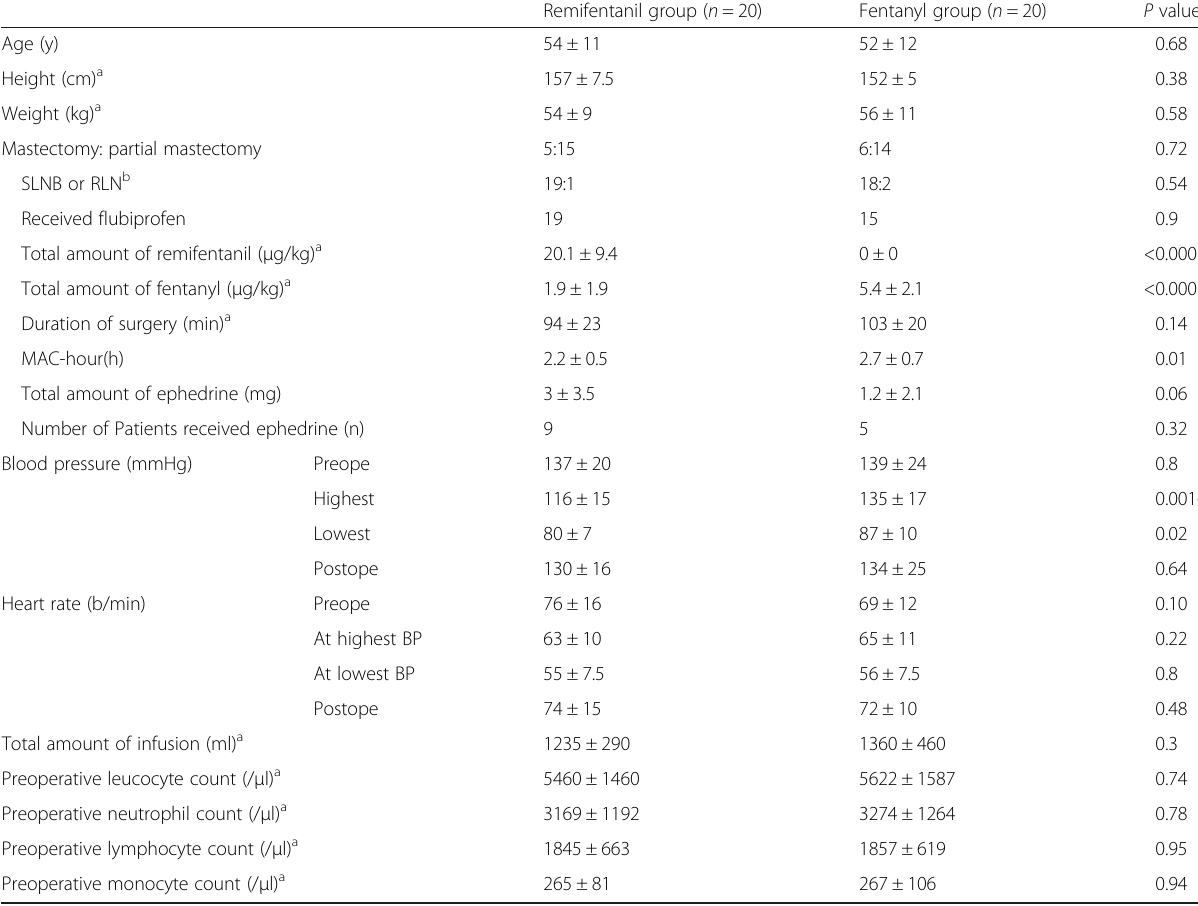
Table 2 Characteristics of the patients who received remifentanil-based anesthesia or fentanyl-based anesthesia after propensity